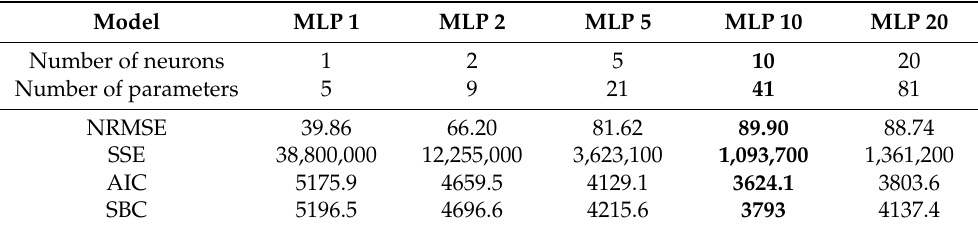
Table 9. Overview of the parameters of the created MLP models and performance metrics of the DMSP-20 muscle validation results.